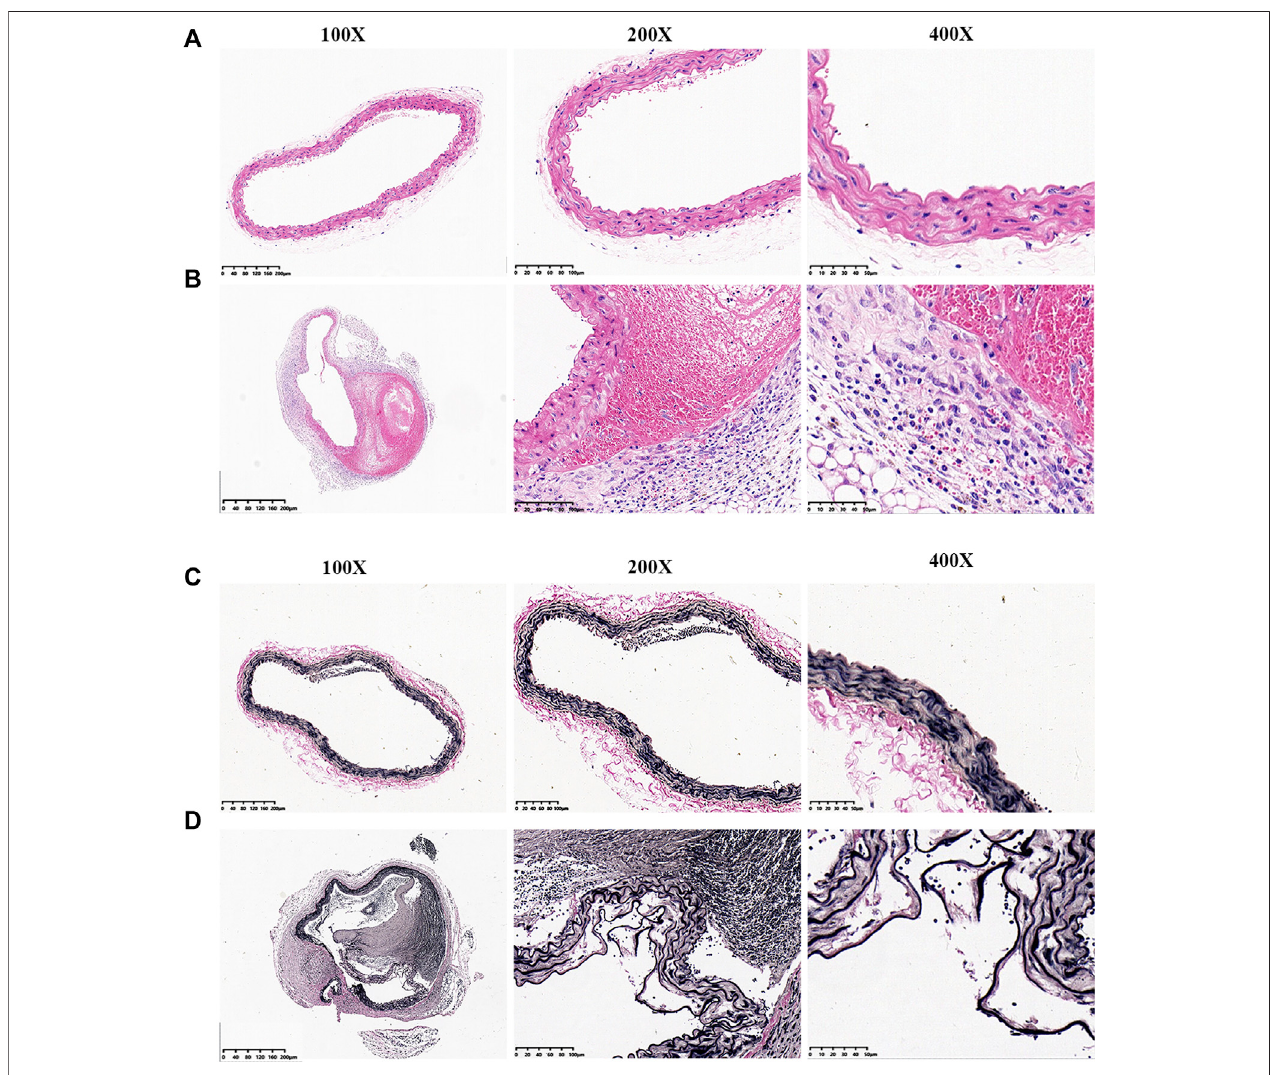
FIGURE 2 | EVG and H&E staining of aortic vessels in mice from each experimental group. (A) H&E staining of normal blood vessels. (B) H&E staining of aortic dissection blood vessels. (C) EVG staining of normal blood vessels. (D) EVG staining of aortic dissection blood vessels.